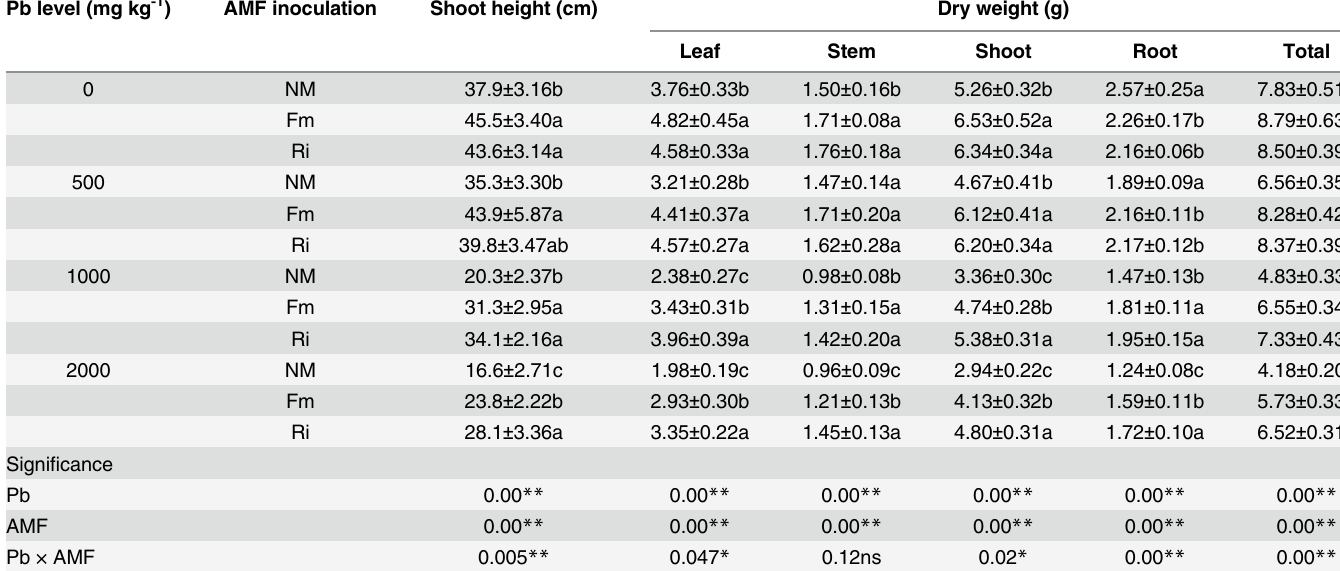
Table 1. The shoot height, the dry weights of the leaves, stems, roots and the total dry weight of Robinia pseudoacacia were affected by Pb stress levels and AMF inoculation. Pb level (mg kg -1 )